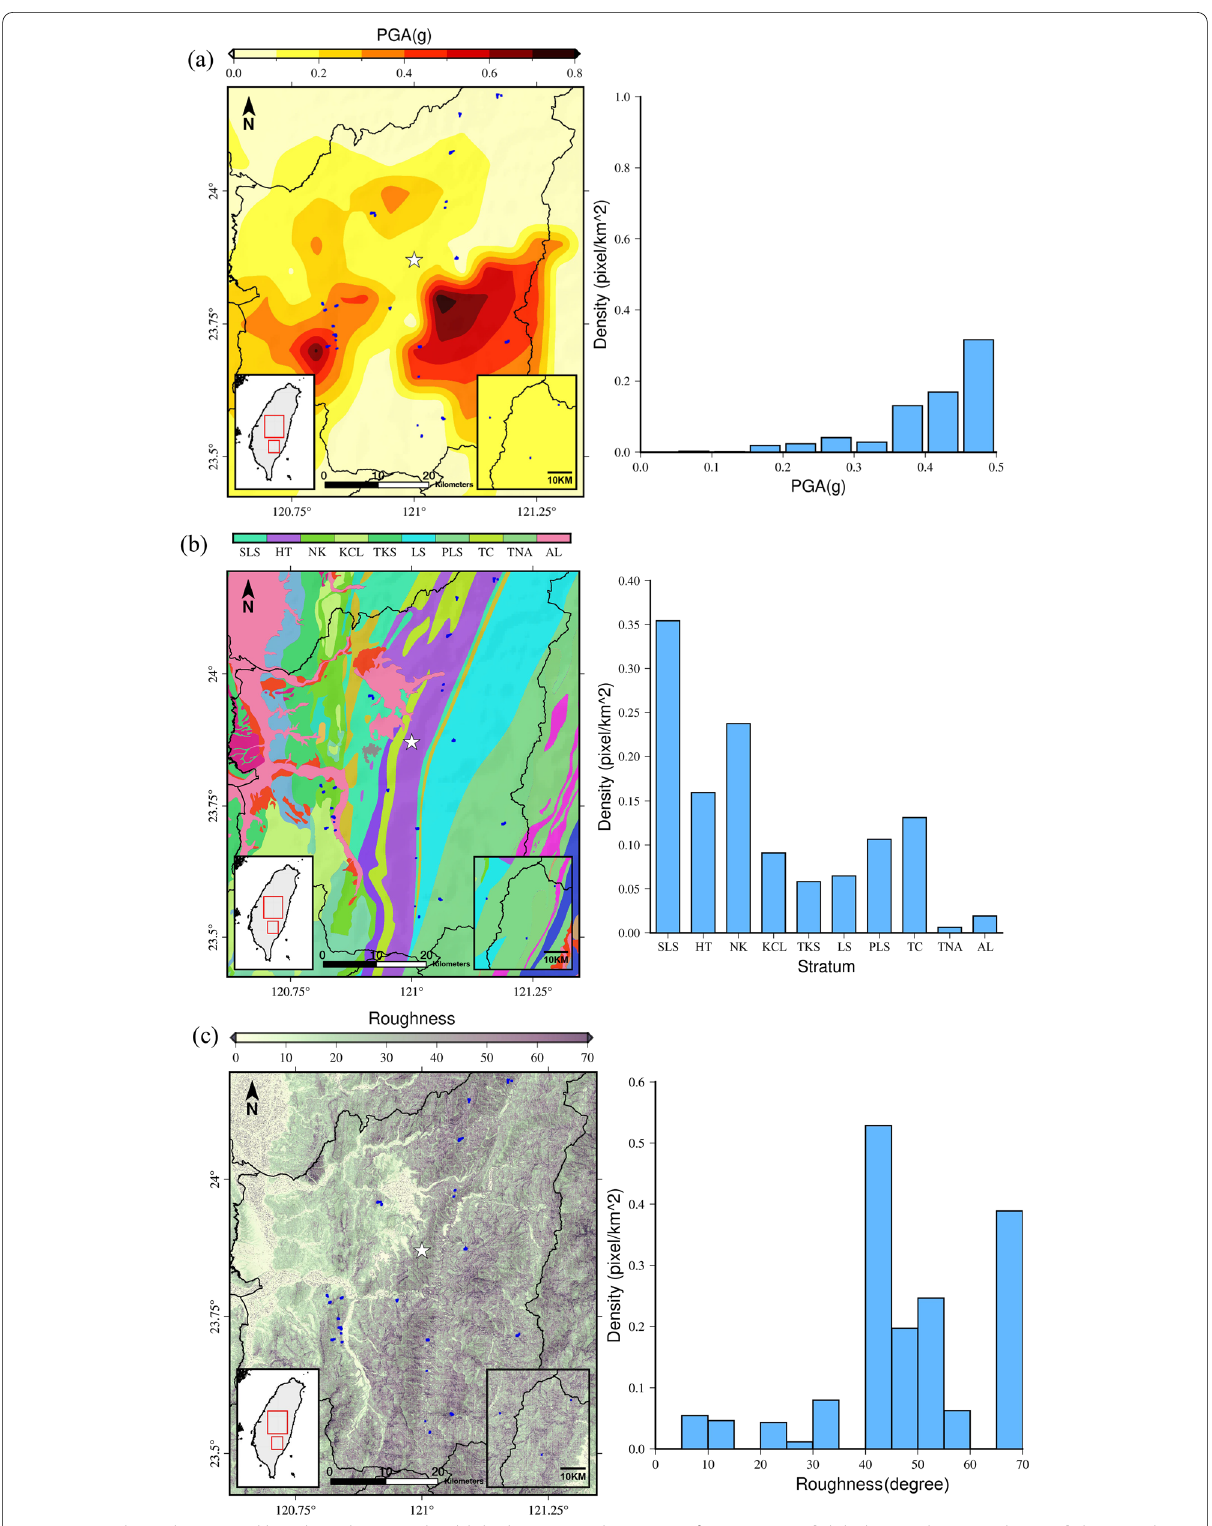
Fig. 2 Spatial correlations and bar charts between landslide densities and triggering factors: a PGA, b lithology, c slope roughness, d slope angle, and e aspect. Slope roughness: the standard deviation of the slope within a 3 3 cell window, SLS Szeleng Sandstone and Paileng Formation; HT × Hsitsun Formation; NK Nankang Formation; KCL Kueichulin Formation; TKS Toukoshan Formation; LS Lushan Formation; PLS Pilushan Formation; TC Tachien Sandstone; TNA Tananao Schist; AL